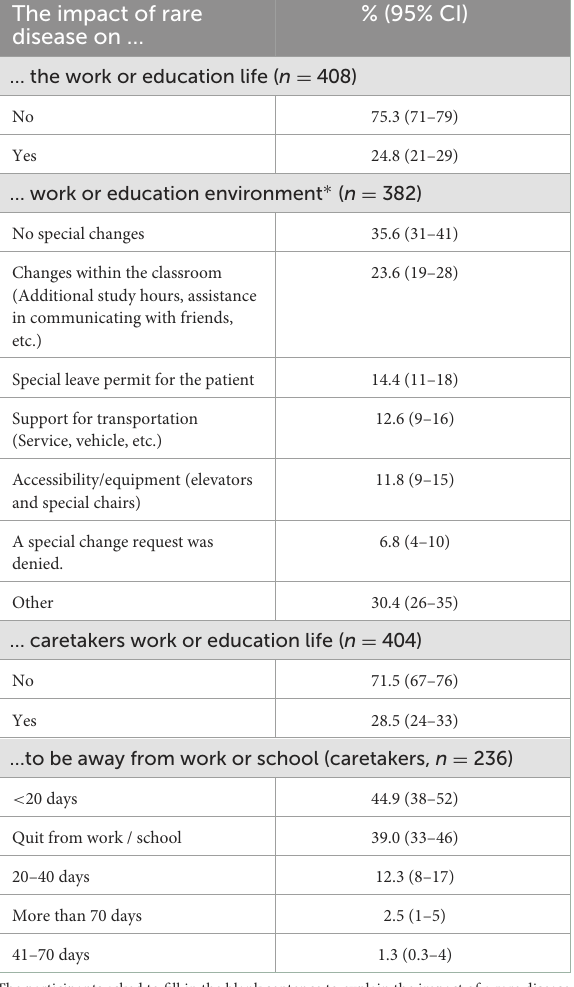
TABLE 4 The impact of rare diseases on patients and caretakers. The impact of rare disease on